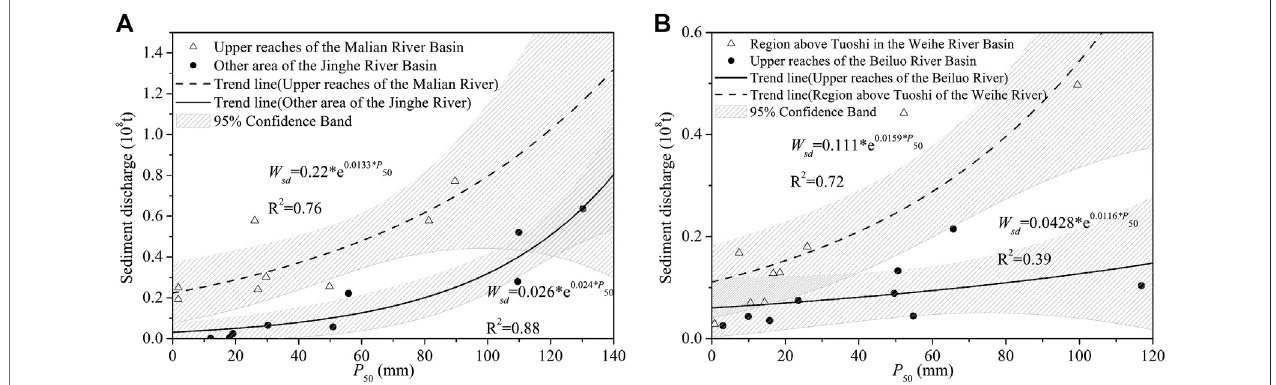
FIGURE 6 | The observed rainfall and annual sediment discharge of (A) the JHR and (B) the WHR and BLR from 2010 to 2018.